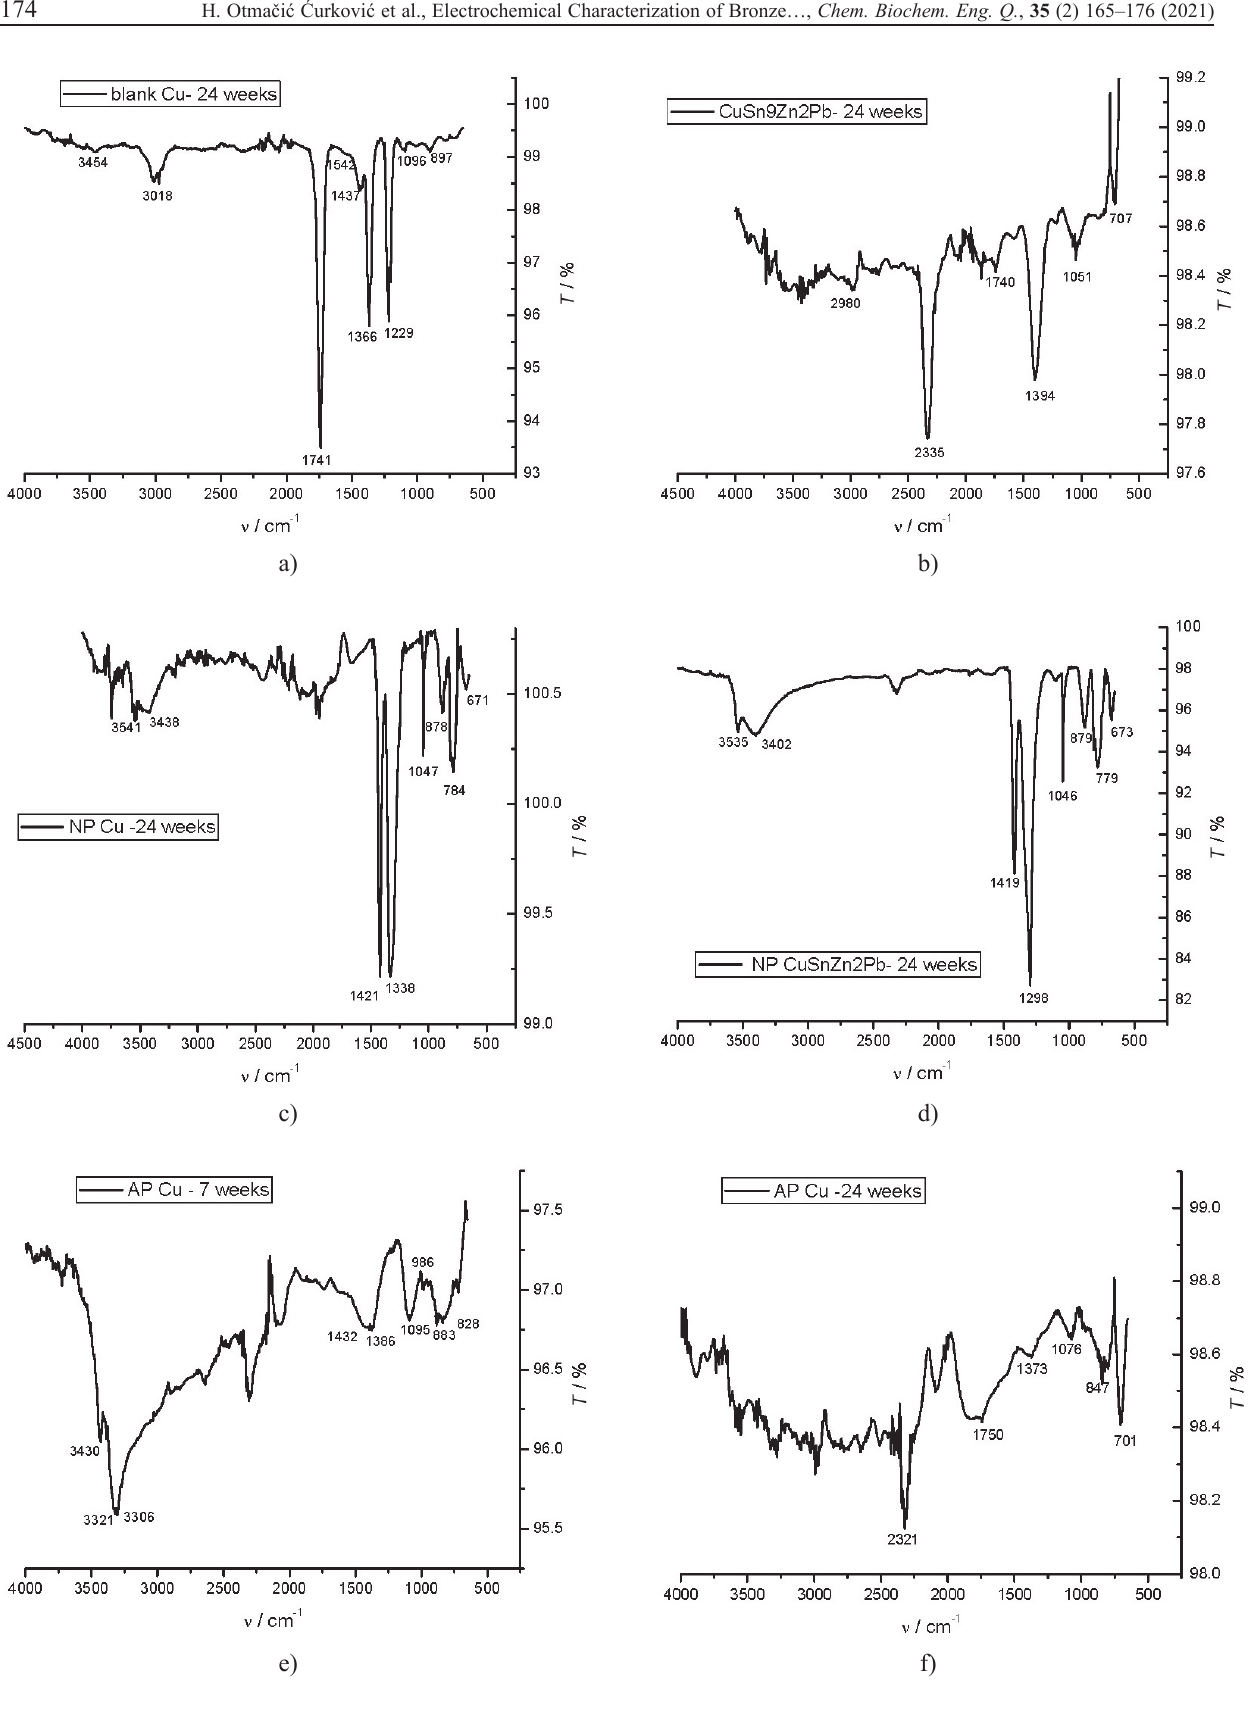
Fig. 6 – ATR-FTIR spectra of studied samples after exposure to outdoor